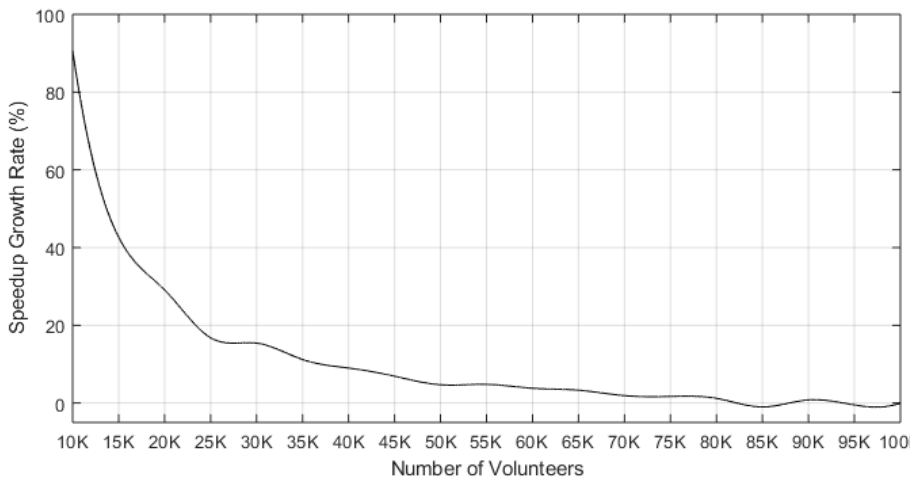
Figure 3. The speedup growth rate in response to overlay size growing.